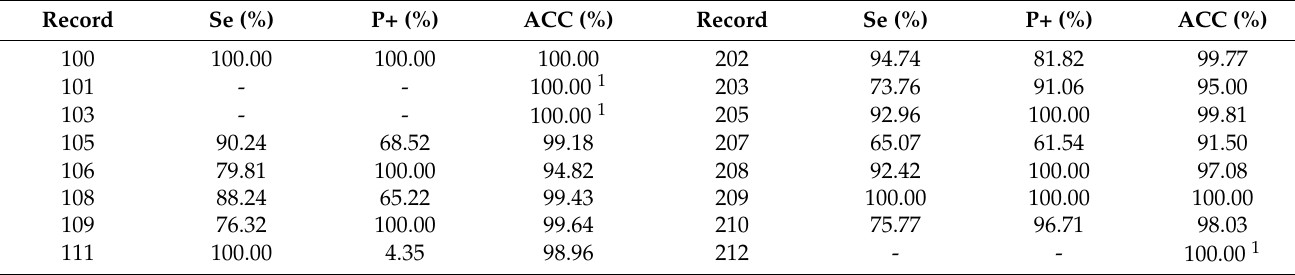
Figure A1. Evaluation indices of the proposed method in 12-lead INCART database. Table A1. PVC recognition results on the MIT-BIH-AR database.